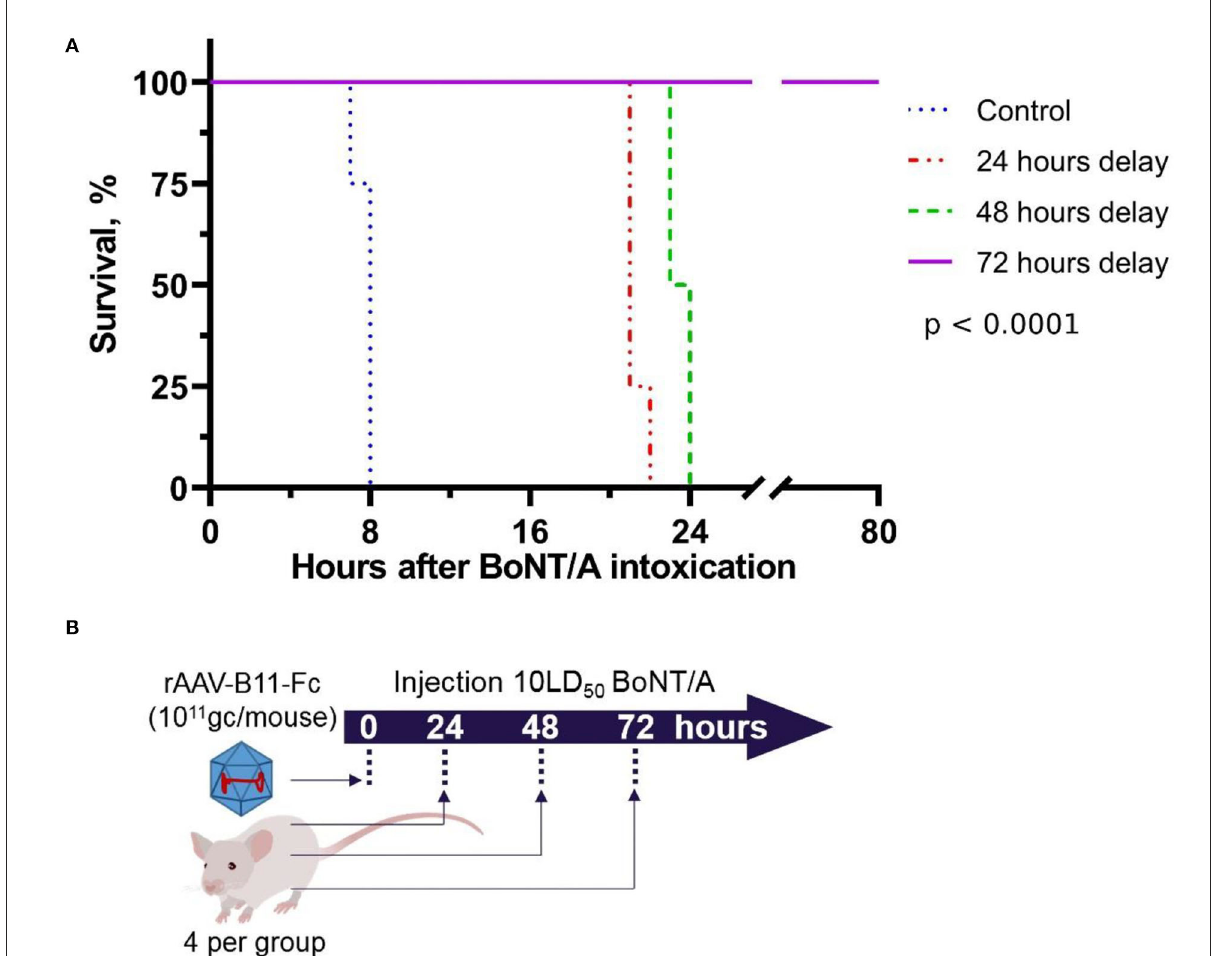
FIGURE3 Survival of mice intoxicated with 10LD50 of BoNT/A at the 24, 48, and 72h after intramuscular injection of rAAV-B11-Fc at a dose of 10 11 gc/mouse. (A) Survival graph. Control – untreated mice, 24h delay – mice which were intoxicated 24h after being treated with rAAV-B11-Fc, 48h delay – mice which were intoxicated 48h after being treated with rAAV-B11-Fc, 72h delay – mice which were intoxicated 72h after being treated with rAAV-B11-Fc. The median survival time was 8h for the control group, 21h for the 24-h delay group, 23.5h for the 48-h delay, and over 80h for the 72-h delay. (B) Scheme of